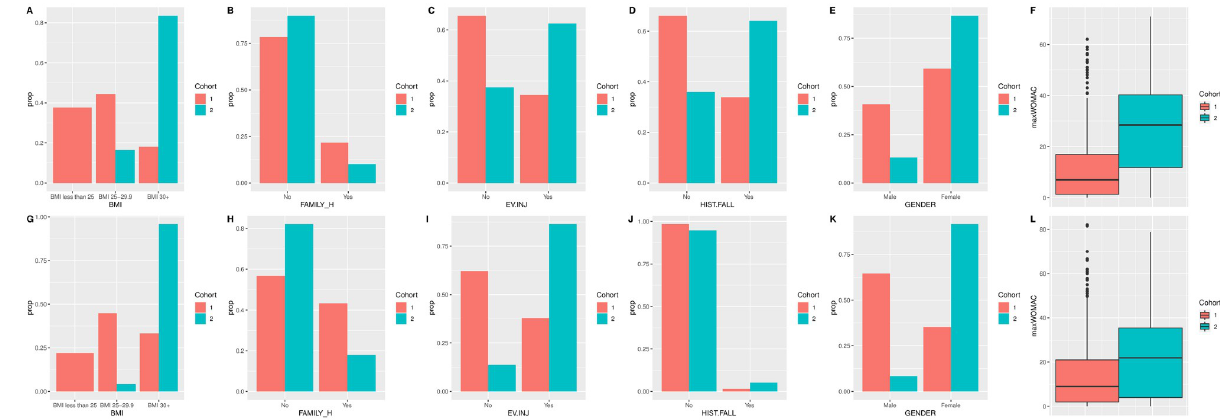
Fig 5. The cohort profiles per variable for the different strata. The red bars show cohort 1 and green show cohort 2. This representation of the profiles is the proportion of the group in each data category per cohort, graphs A-F are for the training set, and G-L are for the validation data.